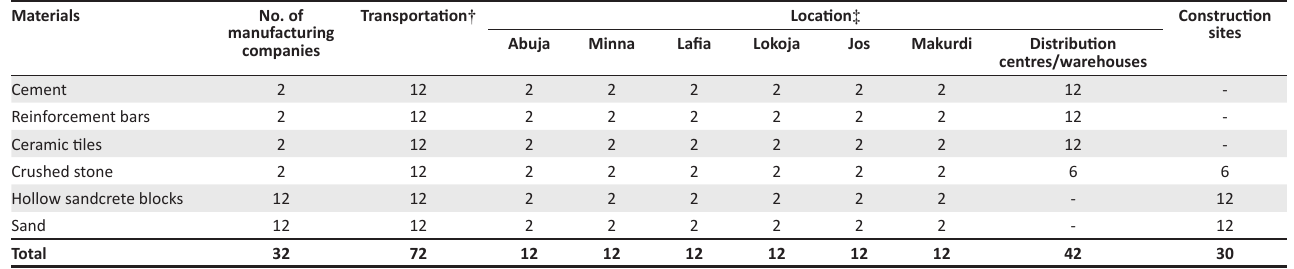
TABLE 2: Summary of data recorded. Materials